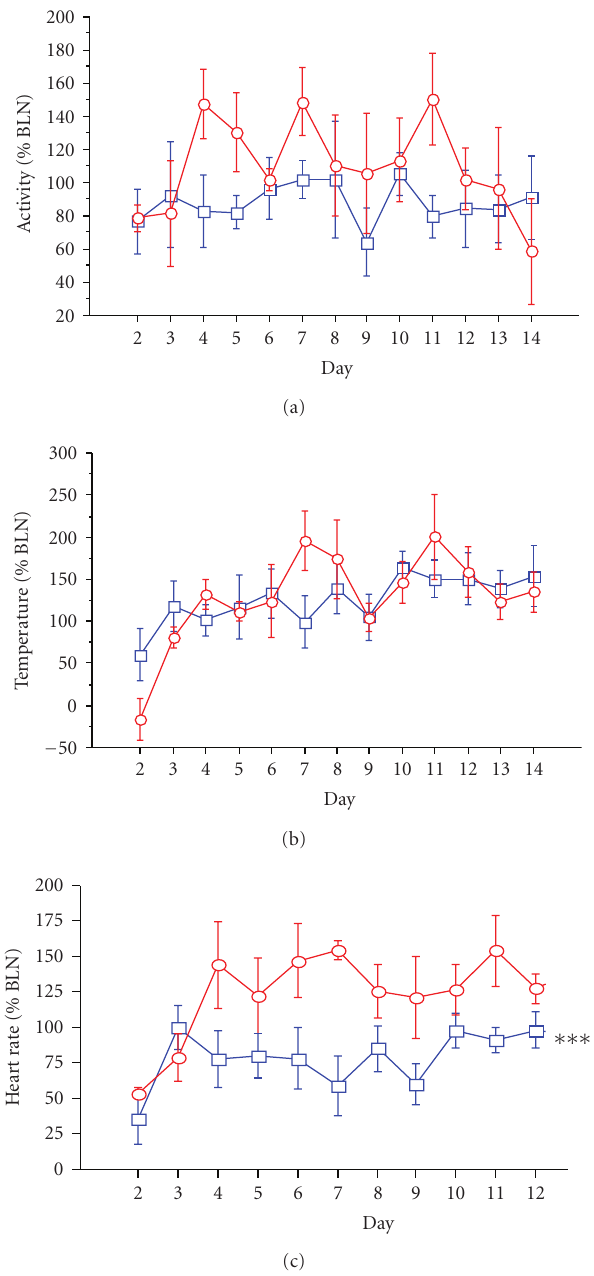
Figure 4: Circadian rhythm data. Normalised data for amplitude values were calculated as post-MFB surgery values as a percentage of mean prelesion (BLN, baseline) data for the circadian parameters of: LA (a), cBT (b), and HR (c), for sham-operated controls and 6- OHDA lesioned rats. Data was taken from the day after MFB surgery (day 2) until 12–14 days after surgery. Data was analysed from day 4, when recovery of HR and body temperature reached levels comparable with the baseline in the lesioned rats. There was no significant change in LA (a) or cBT (b) between groups. However, there was a lower diurnal rhythm of HR for 6-OHDA lesion rats than sham-operated controls (ANOVA: F = 12 . 280, P = . 0057; post hoc group di ff erence ∗∗∗ P < . 0001 ). Circles represent controls; boxes represent 6-OHDA lesioned rats. BT, body temperature, HR, heart rate, LA, locomotor activity.